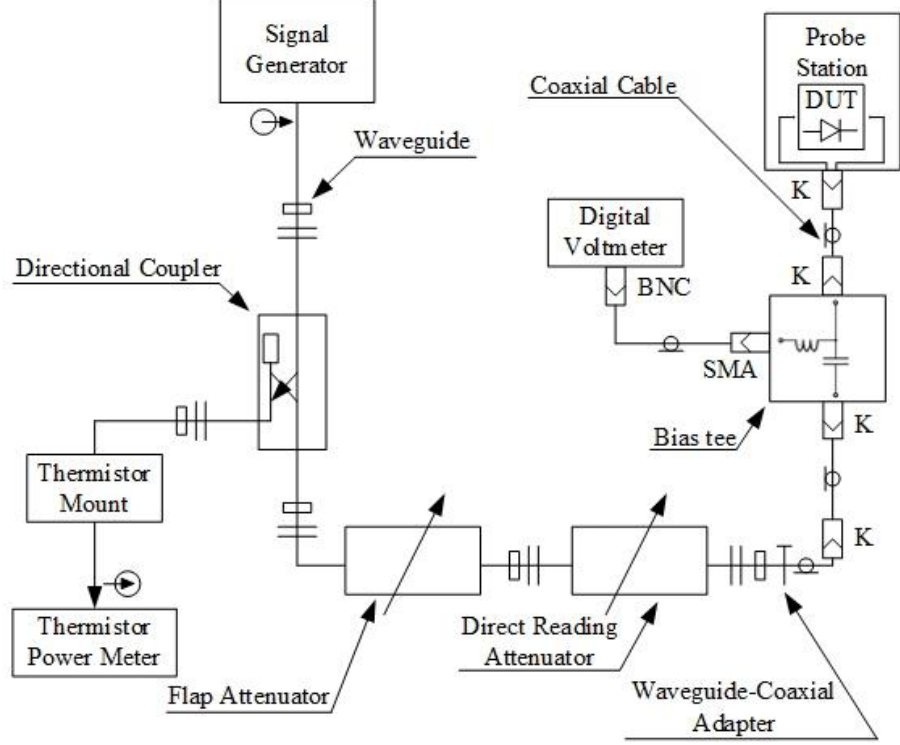
Figure A2. The structure block diagram of the measurement setup.